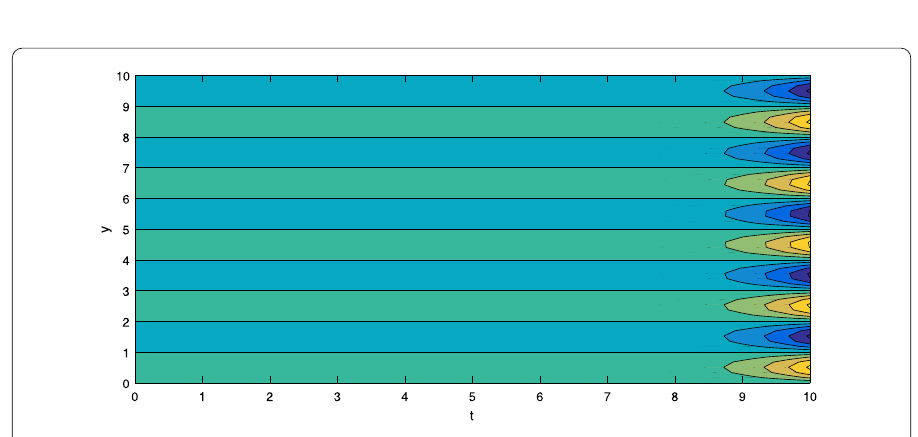
Figure 3 The contour plot of the solution curves given by (47) of fractional heat equation (1) for constant values t = 0.5, z = 0.5 at different values of α = 0.4,0.6,0.8,1.0 in the xy -plane